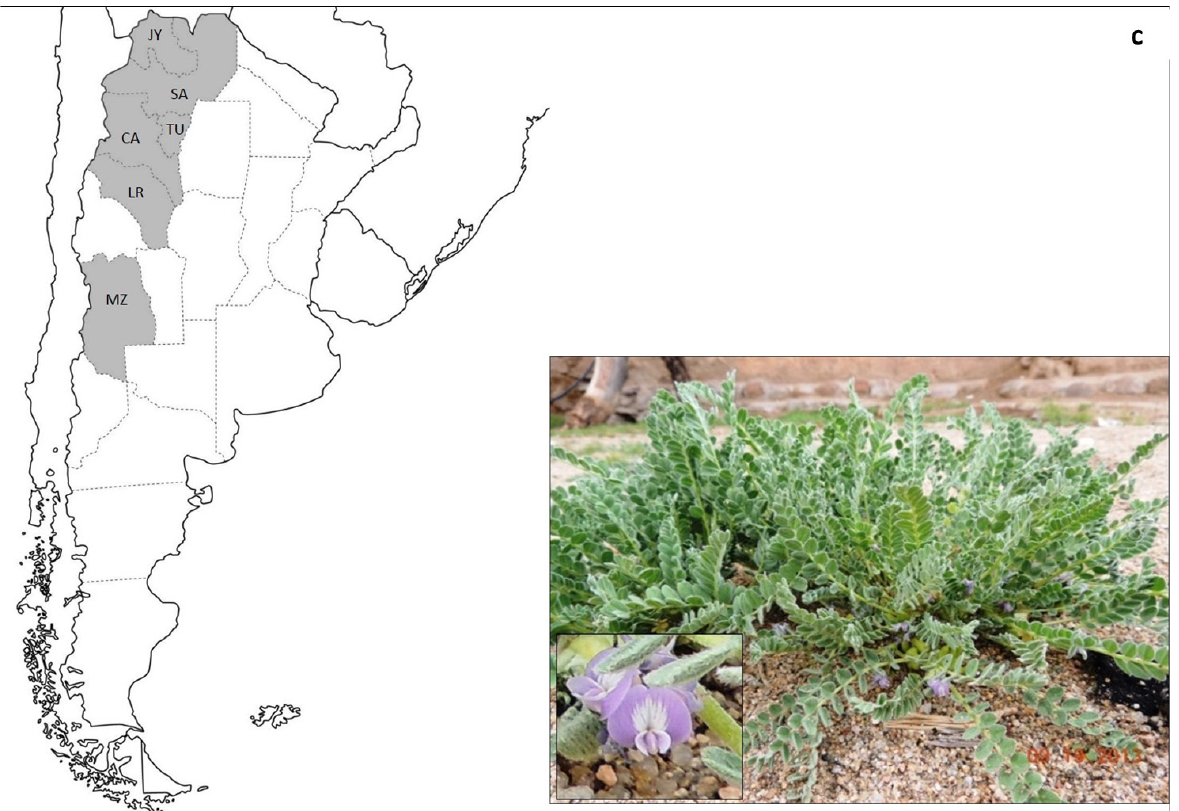
Figure 2c. Distribution of Astragalus garbancillo in